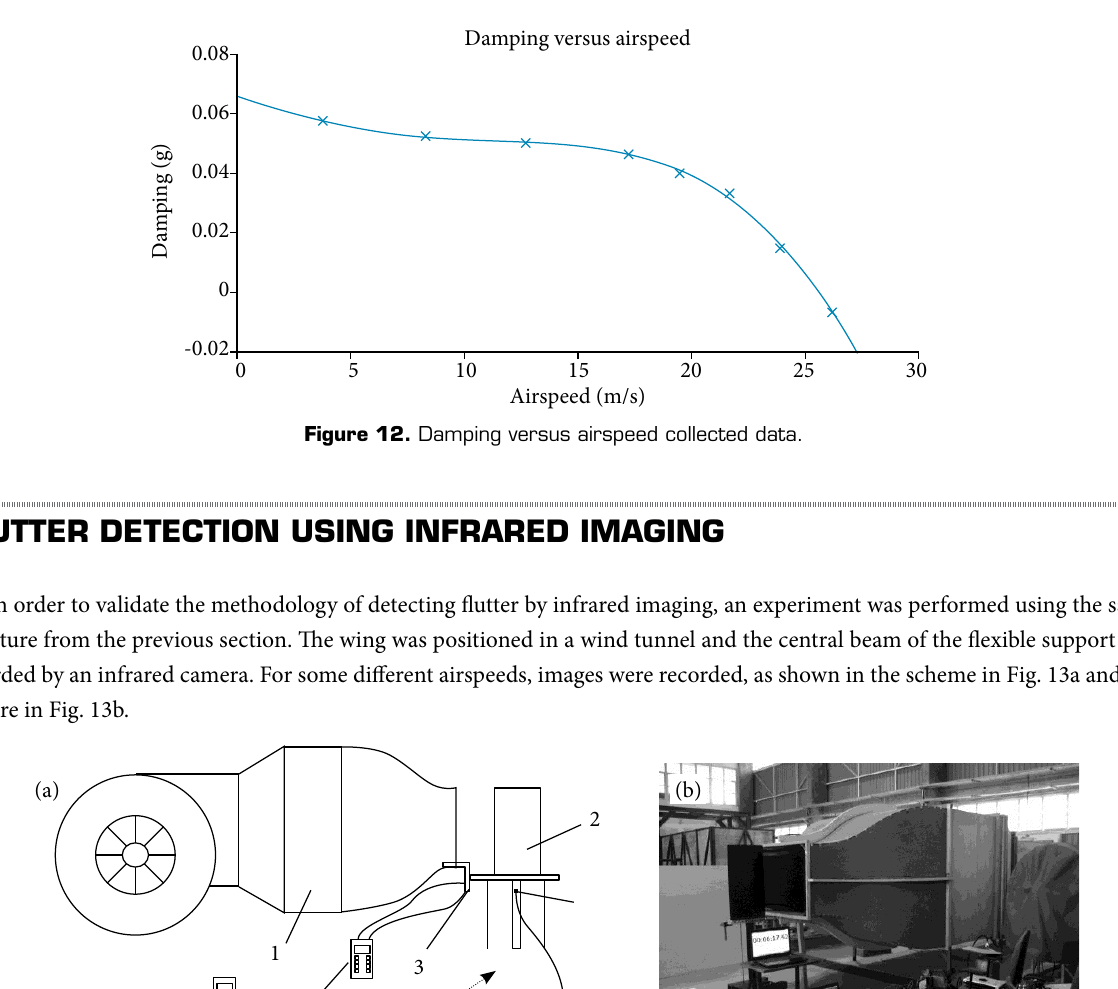
The open circuit wind tunnel (1) provides airflow to the wing mounted on the set support/wing (2). The airspeed was measured in real-time by a pitot tube (3) and a DPCalc Manometer, model 8705-M-GB (4), while the environmental conditions were controlled by a Portable weather station, model Instrutemp ITWH 1170 (5). For each airspeed, the support central beam was recorded by an Infrared Camera, model FLIR P620